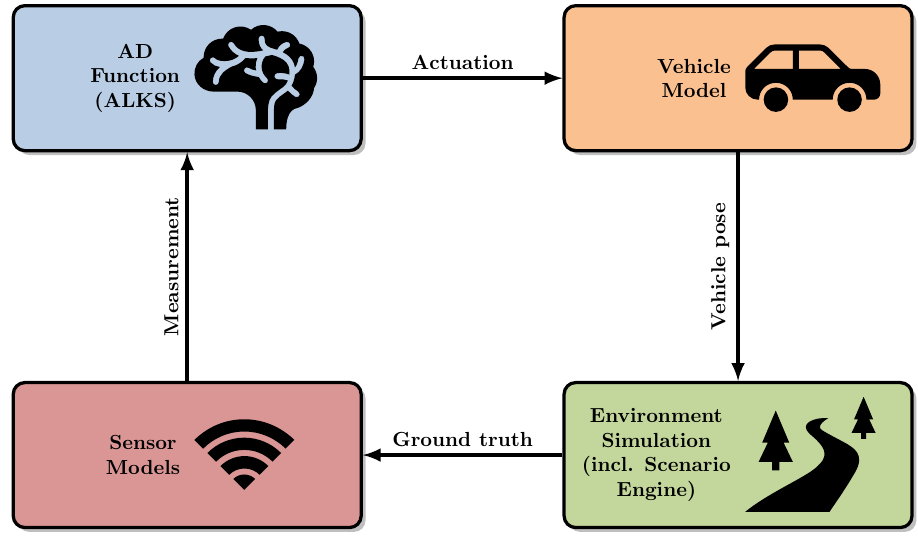
Figure 6. Reduced virtual validation framework for the ALKS with the respective